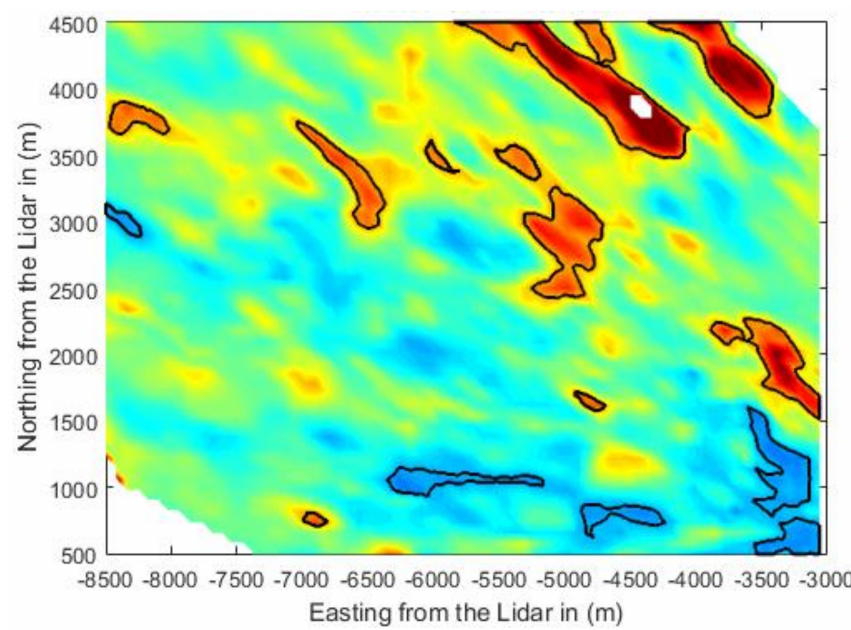
Figure 4. Retrieved wind field with detected boundaries of gust regions. Black contours are the boundaries of the detected